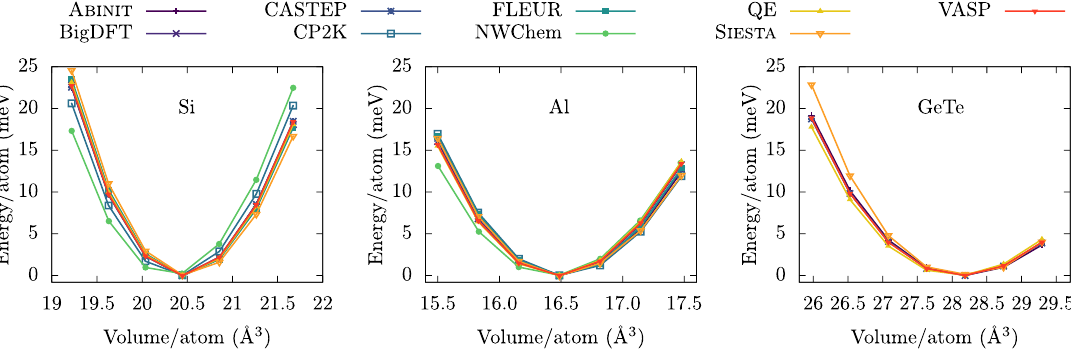
Fig. 7 EOS for Si, Al, and GeTe. Results obtained with the code-agnostic EquationOfStateWork fl ow . For each code, the energy is shifted to set the minimum energy to zero. The EOS has been computed with all codes discussed in this work, except ORCA and Gaussian, which are mainly specialized for non-periodic systems. In addition, for GeTe, results are missing for BigDFT, CP2K, FLEUR, and NWChem (see Supplementary Table 2 for more details). The label QE stands for Quantum